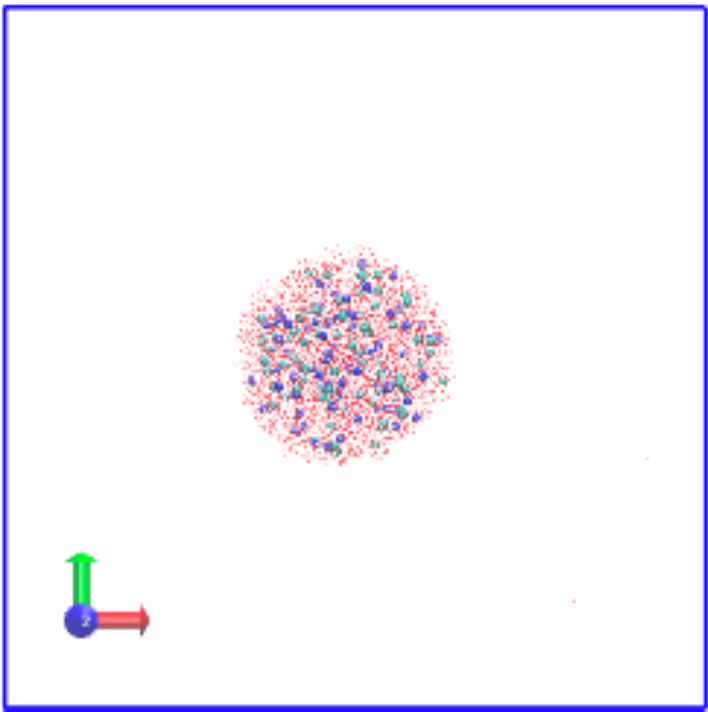
Figure A1. A 1m NaCl droplet with 5000 water molecules in a simulation cell of edge length of 21nm. Simulation cell boundaries are represented as blue lines.